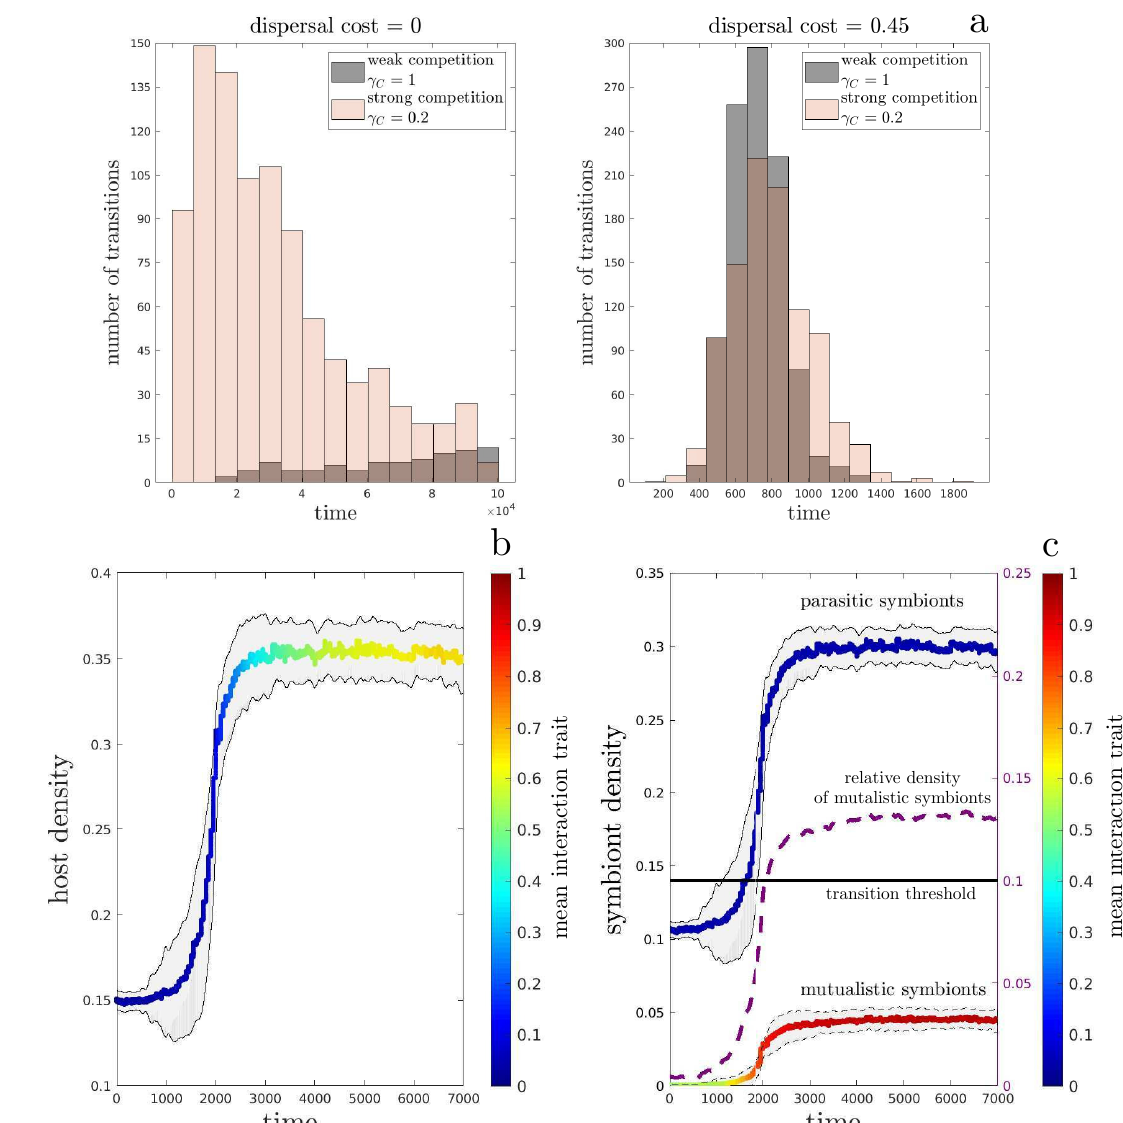
Figure 2. a) Histograms of the number of transitions over 1000 simulations as a function of time, with a max- 5 imum projection time of 10 . Without dispersal cost there are a total of 86 transitions when the competition is weak and 951 when the competition is strong. With dispersal cost there are 1000 transitions whether the competition is weak or strong. Panels b) and c) represent the host and symbiont densities over time averaged over 100 simulations (coloured plain curves) under strong competition γ C = 0 . 2 and no dispersal cost d = 0 4 and with a maximum projection time of 10 steps. The densities correspond to the proportion of occupied cells. The time series are adjusted so that all simulations have a transition time t = 2000 . The colour gradi- ent corresponds to the mean interaction trait α , and shaded regions correspond to the standard deviation for densities. In panel c), the purple dotted line and the right y-axis show the relative density of mutualistic symbionts, and the black line indicates the 10% transition threshold. For all panels, other parameters are m = 0 . 06 , c m = 0 . 3 , w h = 1 , f h = 0 . 1 , f s = 2 . 5 , f max = 8 , f a = 0 . 5 and β max = 0 . min min